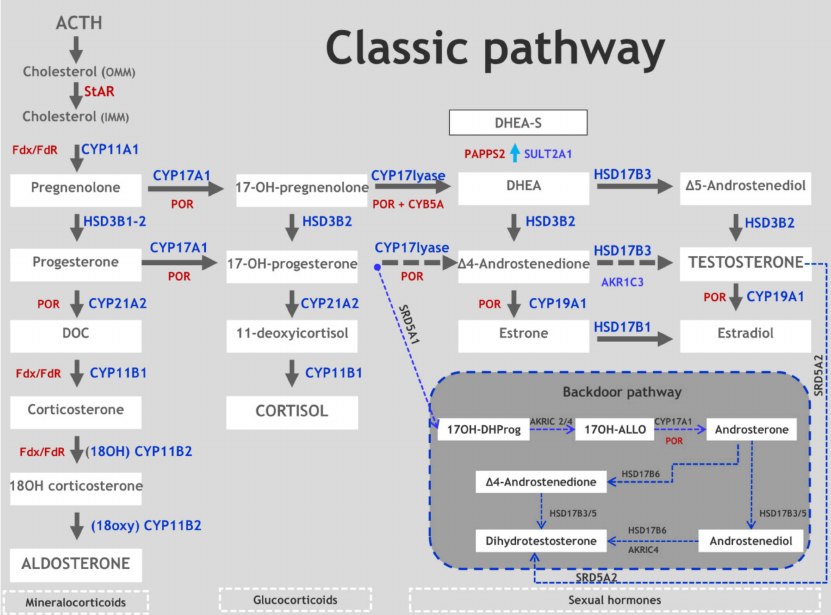
Figure 1. Adrenal and gonadal steroidogenesis (Classic and Backdoor pathways). StAR, steroidogenic acute regulatory protein; OMM, outer microsomal membrane; IMM, inner microsomal membrane; DHEA / DHEA-S, Dehydroepiandrosterone / D-Sulfate; DOC,